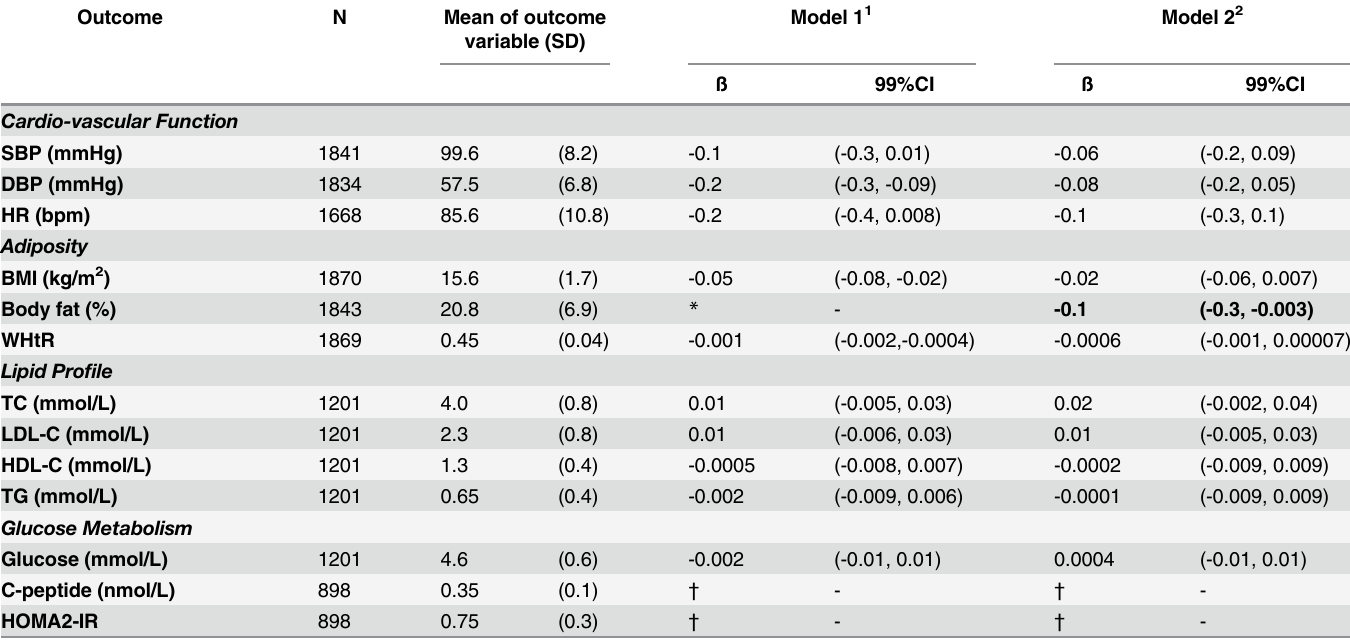
Table 3. Linear regression models of the association between maternal 25-hydroxyvitamin D concentration in early pregnancy and cardio-meta- bolic outcomes in 5 – 6 year old children (per 10 nmol/L increase of 25-hydroxyvitamin D) with testing for interaction with pre-pregnancy BMI. Outcome N